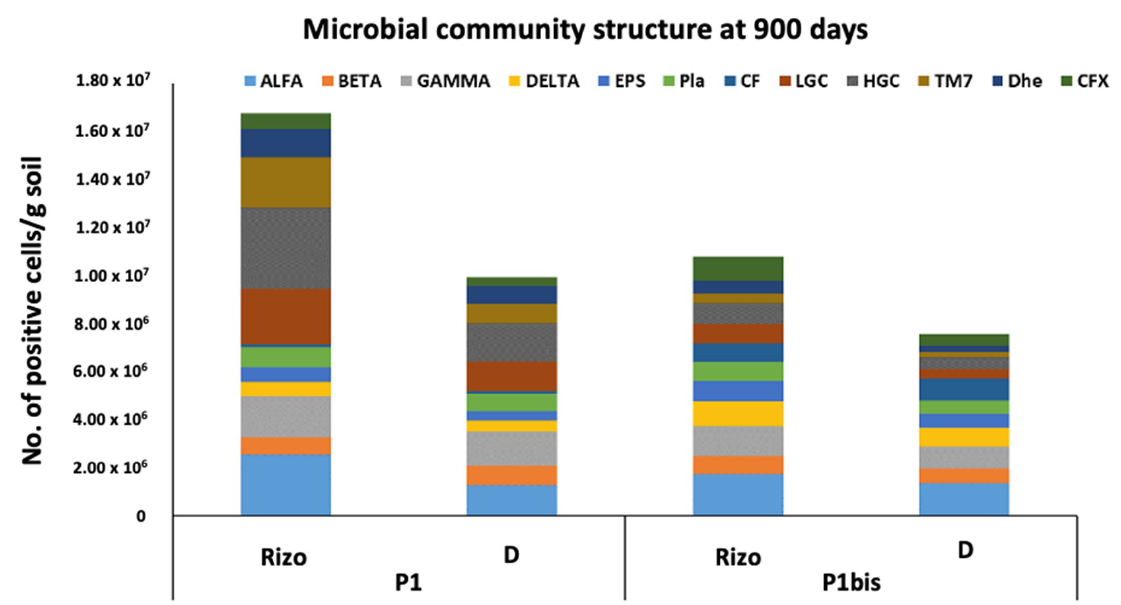
Figure 5. Bacterial community structure detected by the fluorescence in situ hybridization (FISH) method at day 900 in the rhizosphere and D soil (1 m distance from the trunk and 20–40 cm depth) in the P1 and P1bis plots. ALFA = Alpha- Proteobacteria ; BETA = Beta-Proteobacteria ; GAMMA = Gamma - Proteobacteria ; DELTA = Delta-Proteobacteria ; EPS = Epsilon- Proteobacteria ; Pla = Planctomycetes ; CF = Cytophaga-Flavobacter ; LGC = Firmicutes ; HGC = Actinobacteria ; TM7 = Candidatus Saccharibacteria ; Dhe = Dehalococcoides, CFX = Chloroflexi .